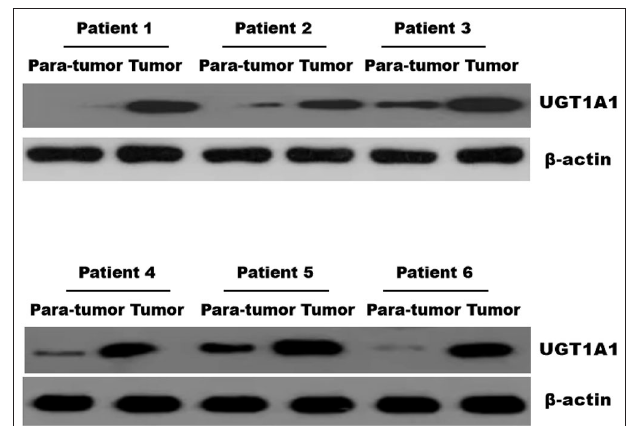
FIGURE 2 | The expression of UGT1A1 in tissues of patients with TNBC. Moreover, the expression of UGT1A1 in tumorous tissues of patients with TNBC was much more than in the matched para-tumorous